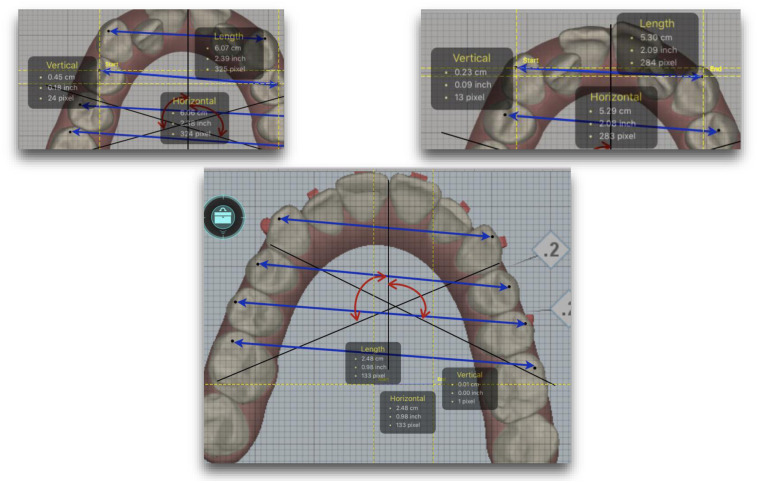
Occlusal images of the maxilla applying the software’s “Grid” tool.